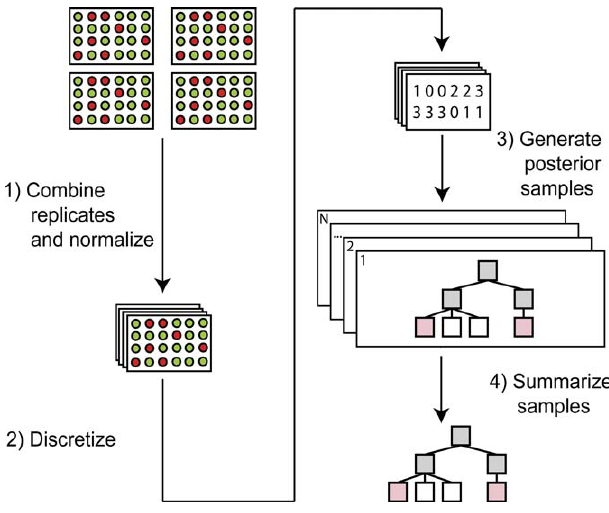
Figure 1. GeneProgram Algorithm Steps The main steps of the algorithm are: data pre-processing (steps 1–2), model inference/learning (step 3), and model posterior distribution summarization (step 4). See the text for details.